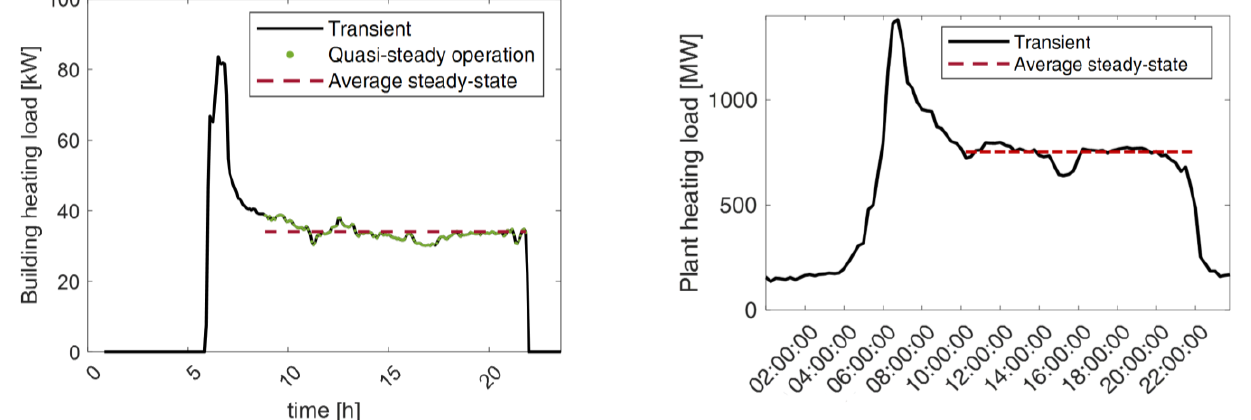
Figure 1. Representation of the heating load of a building ( left ) and of the plants ( right ) during a typical winter day for a large-scale DHN located in Italy.